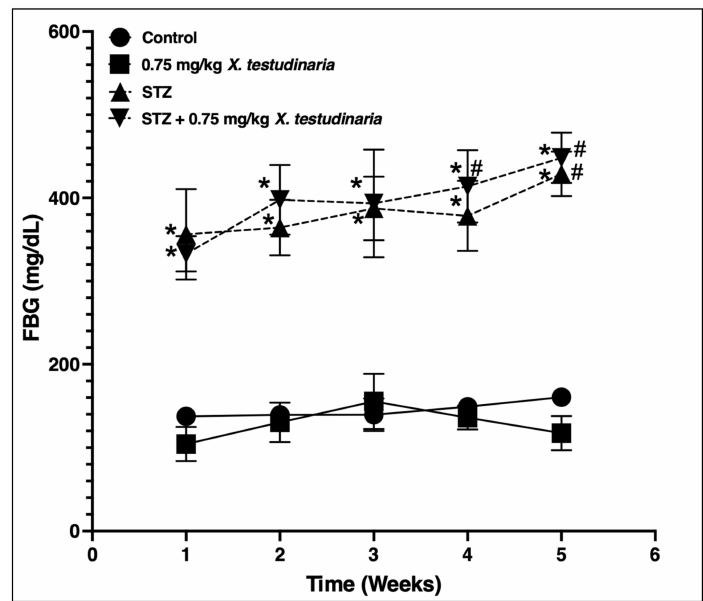
Figure 6. Fasting blood glucose (FBG) level in streptozotocin (STZ)-induced diabetic mice. Data are presented as mean ± SD for the mice (n = 6) in each group. Statistical analysis was carried out using a one-way ANOVA followed by Tukey post hoc test. *: statistical significance from the corresponding control group was set at p < 0.05. #: statistical significance from the corresponding week 0 was set at p <